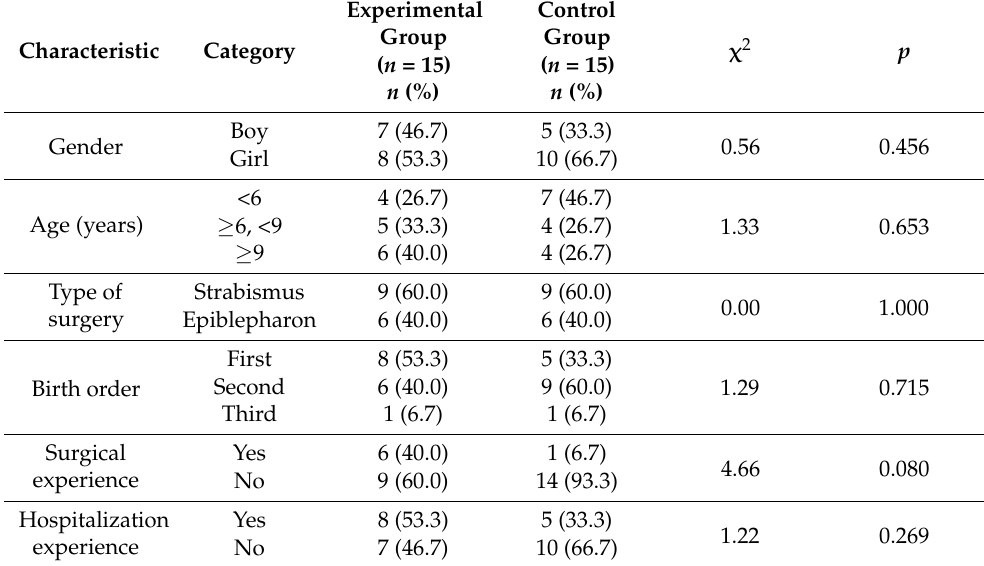
Table 2. Homogeneity test for participants’ general characteristics.